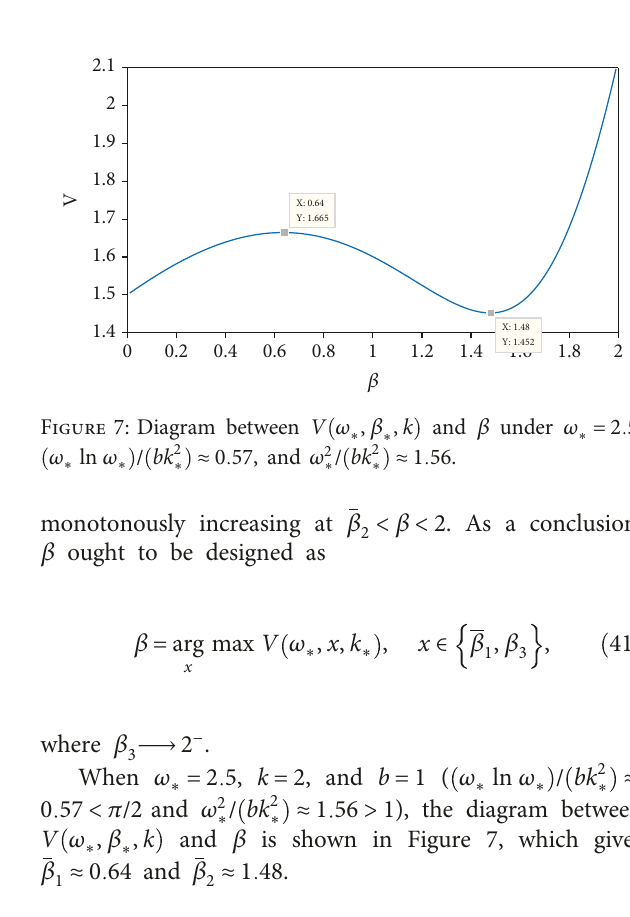
Figure 5: Diagram between V ω ω ω ≈ 3 3 2 ∗ ln ∗ / bk ∗